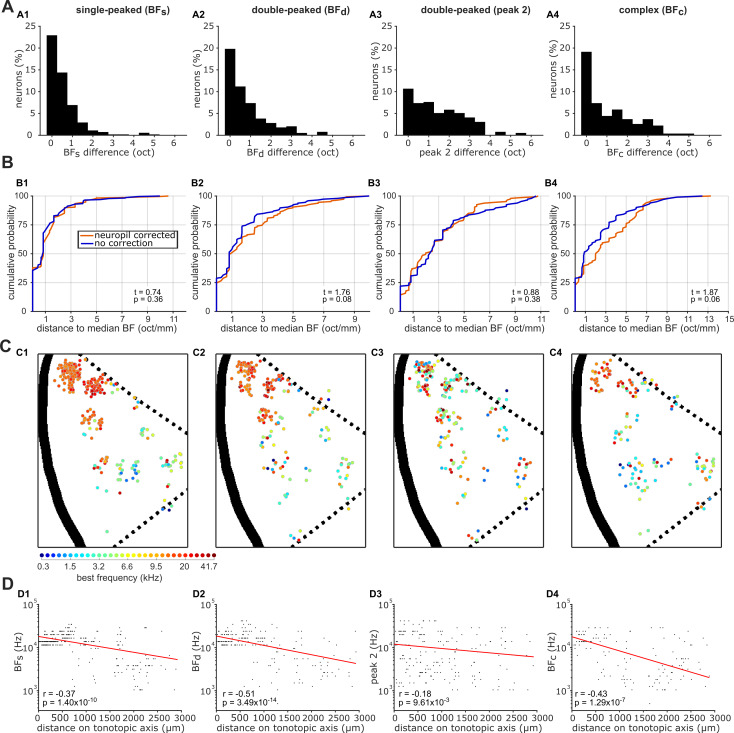
Effects of neuropil contamination on local and global tonotopic organization.(A) Distributions of the difference (in octaves) between BFs (A1), BFd (A2), peak 2 (A3) and BFc (A4) calculated with and without neuropil signal subtraction. (B) Cumulative probability plots of the difference (in octaves) between each neuron’s BF and the median BF of all frequency sensitive neurons in the same imaging field. Distributions for BFs obtained with (red) and without (blue) neuropil correction are plotted separately. The results of t-tests between the two distributions are given in the bottom right of each plot. (C) Frequency preferences are mapped onto a template A1 as in Figure 4A, but here without neuropil correction. (D) Scatterplots show the frequency preferences of neurons as a function of their position along the tonotopic axis of the maps in C (as in Figure 4C), for neuropil-uncorrected data.